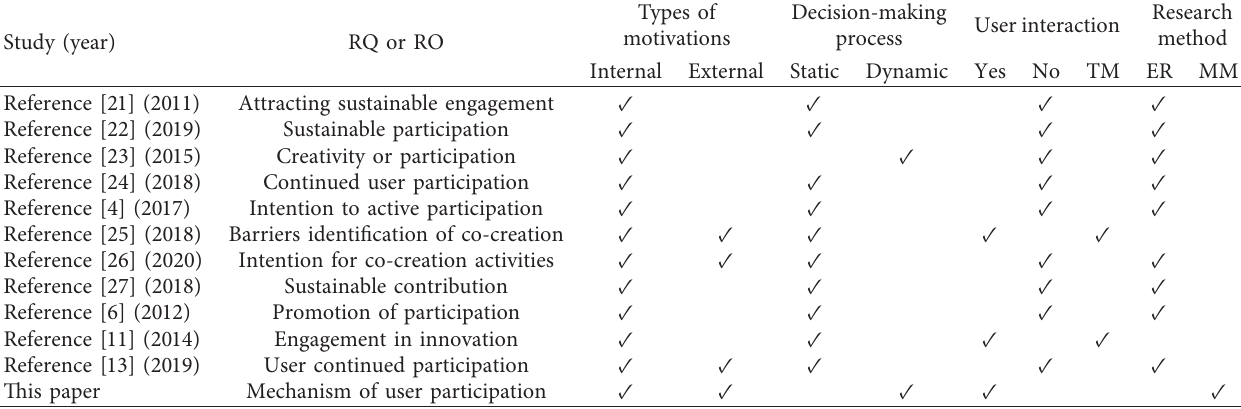
Table 1: Summary of recent studies on user participation in co-creation